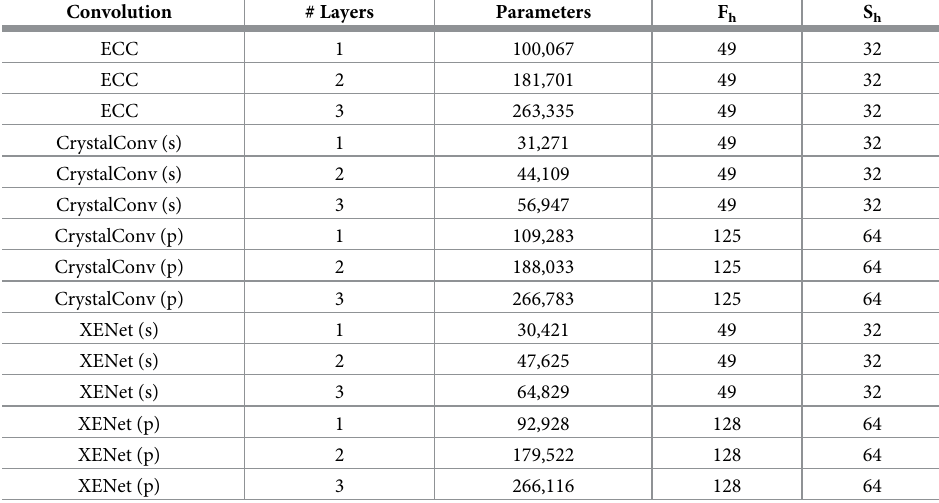
Table 1. Hidden layer sizes and number of trainable parameters for all models. F h is the number of channels for hidden X layers and S h is the number of channels for hidden E layers. Convolution #